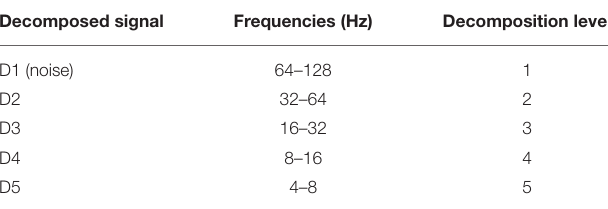
TABLE 1 | Wavelet signal frequencies for different decomposition levels. Decomposed